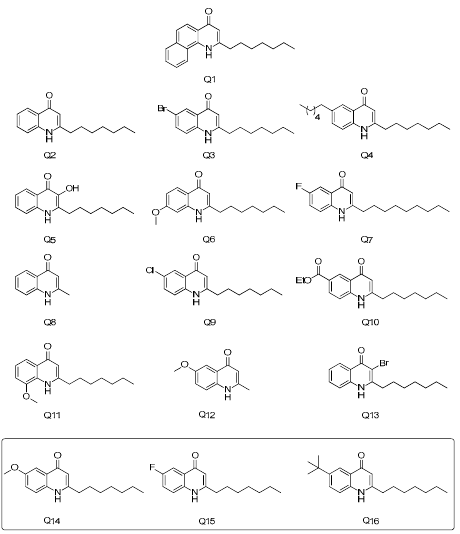
Figure 2. Chemical structure of Quinolones compounds.